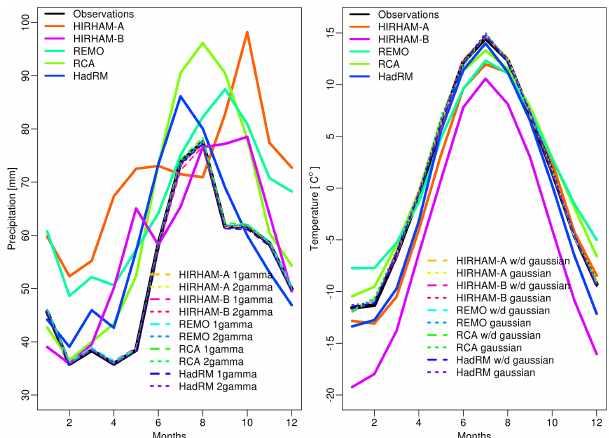
Figure 4. Monthly mean precipitation accumulation (left) and tem- perature (right) in observations and RCMs in Finland during the control period 1961–2000. Observations (black) and uncorrected RCMs (colours) in solid lines, adjusted RCMs in dashed and dotted lines. Monthly mean precipitation adjusted with single gamma (1- gamma) are presented as dashed lines, and with double gamma (2- gamma) as dotted lines (left panel). Monthly mean temperatures ad- justed with wet–dry state separation (w–d Gaussian) are presented as dashed lines and without wet–dry separation (Gaussian) as dot- ted lines (right panel). All adjusted values follow closely the ob- servations and no big differences can be seen between the two bias correction